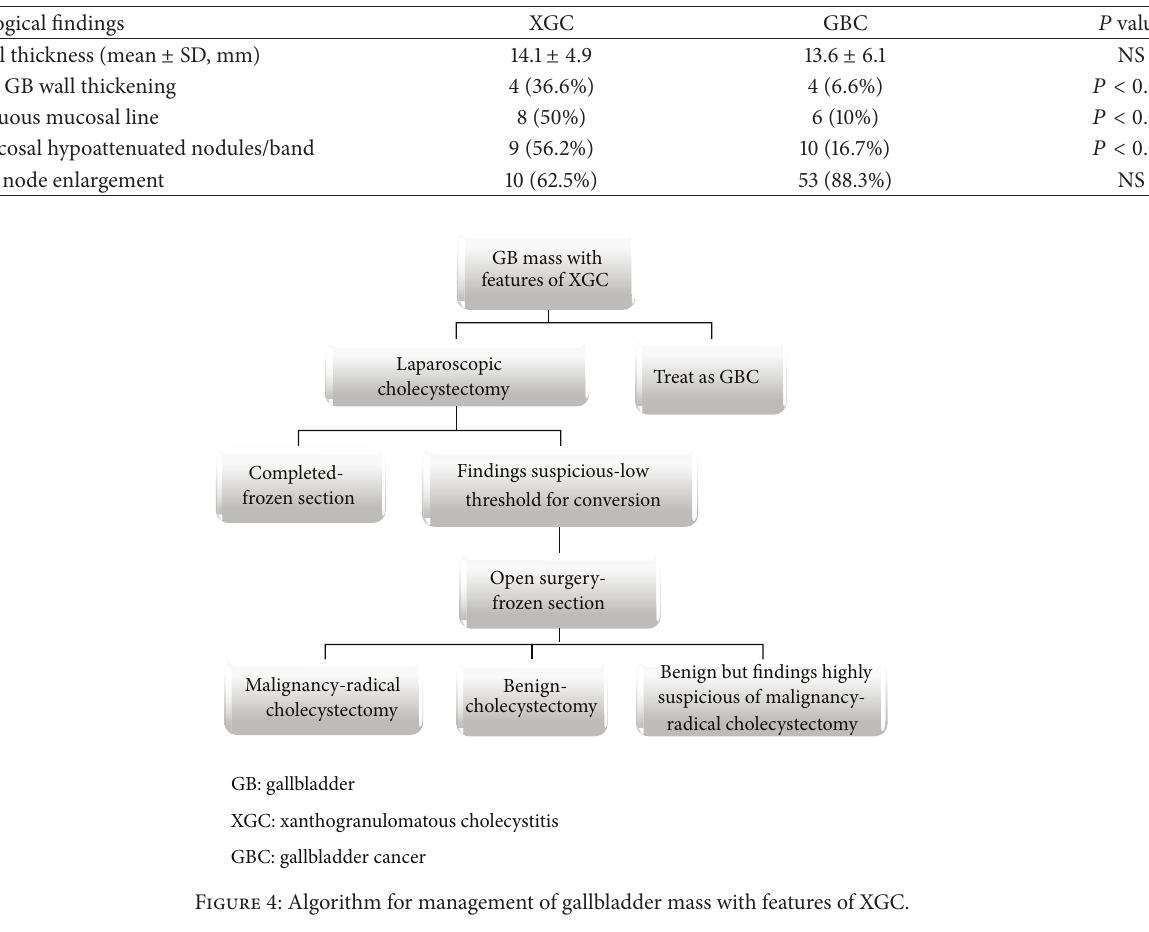
Table 2: Comparison of radiological findings between XGC and GBC.